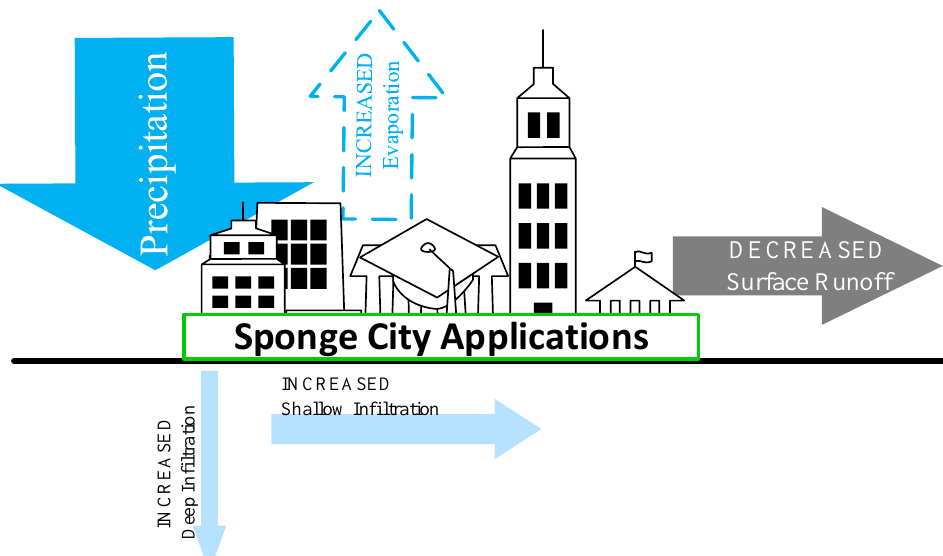
Figure 2. Water flow direction and percentage in an urbanized area with the addition of many SC applications.